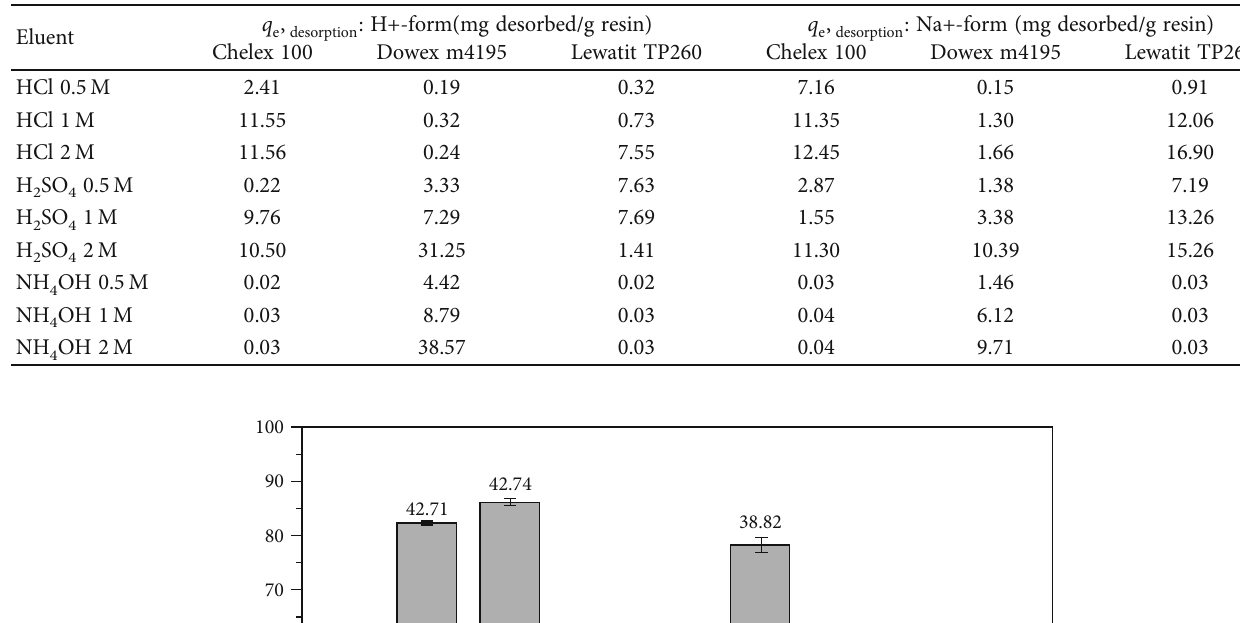
q , desorption : Na+-form (mg desorbed/g resin) e